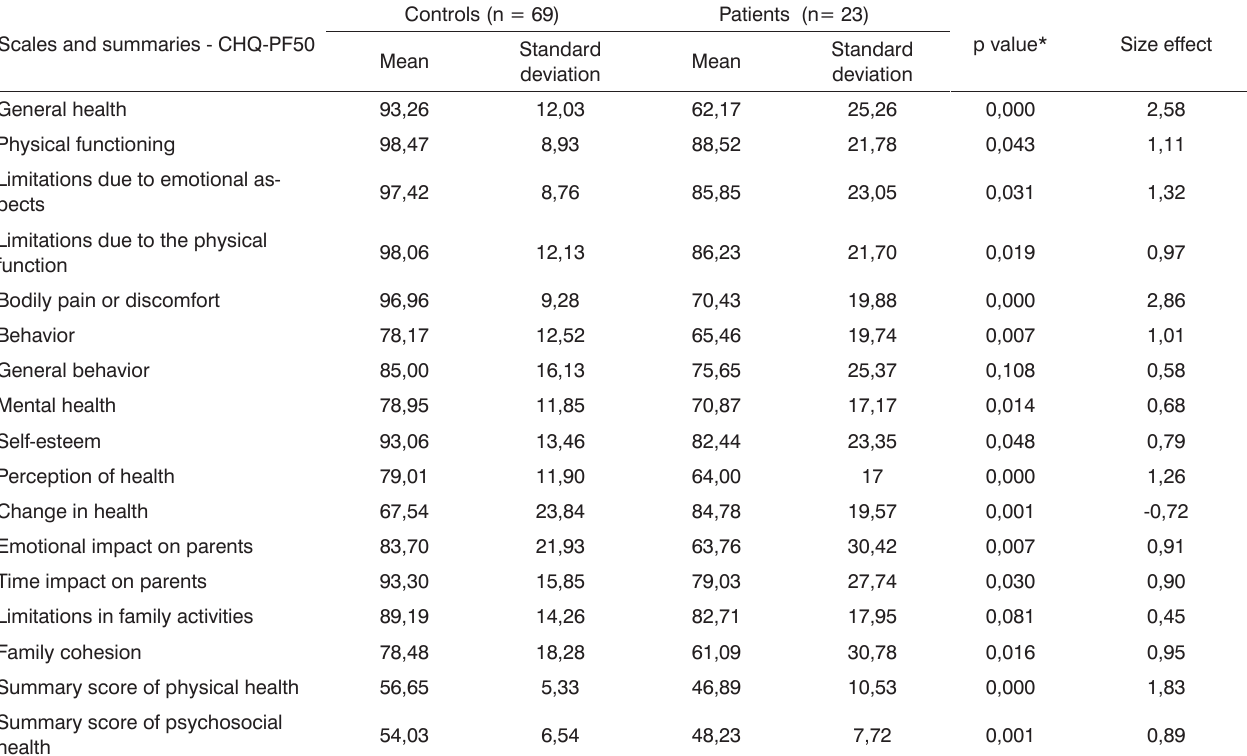
Table 3. CHQ-PF50 scores in patients and controls